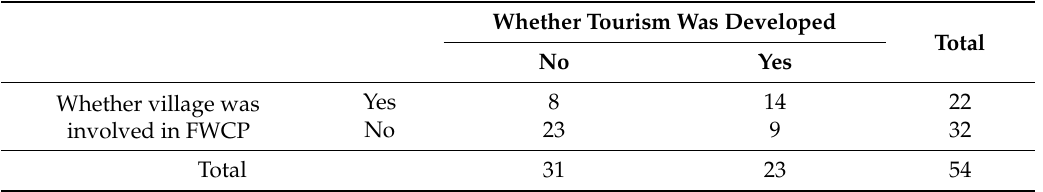
Table 5. Contingency table of the Farmland to Wetland Conversion Progam (FWCP) groups and tourism.